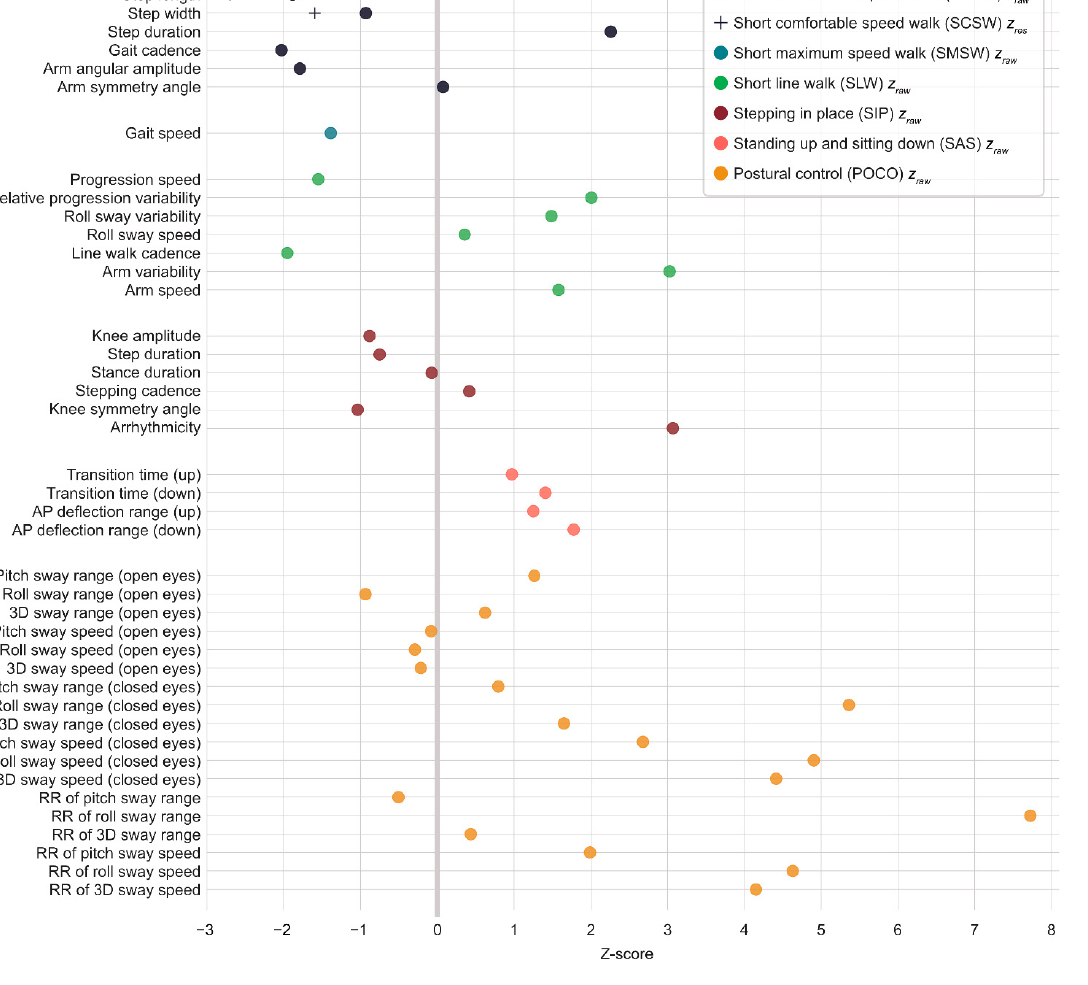
Figure 3. Z-score transformed spatiotemporal parameters from recordings of a randomly picked person with multiple sclerosis from the Valkinect study. Abbreviations: AP: anterior-posterior; RR: Romberg ratio; z raw : z-score for raw values; z res : z-score for residual values.